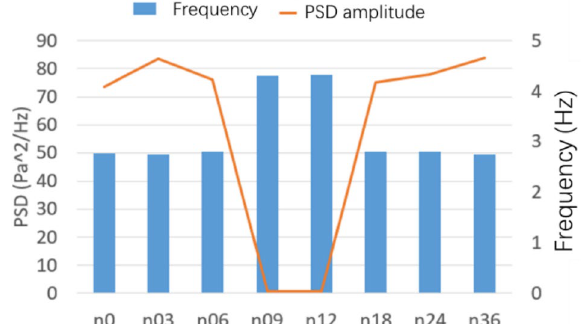
Figure 32. PSD coefficient of number of spoiler.